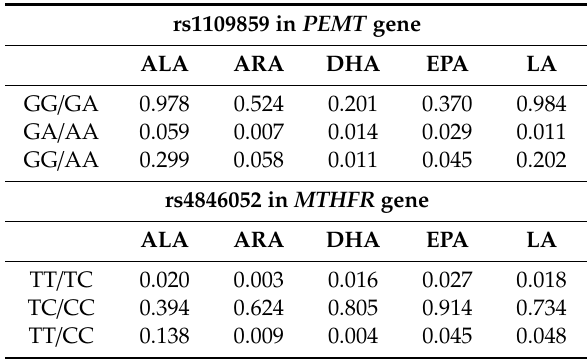
Table A3. The p values for the Mann–Whitney U test used to evaluate di ff erences between PUFA measured in red blood cell membranes in regards to rs1109859 PEMT , and rs4846052 MTHFR genotypes. Test is significant at p ≤ 0.05.